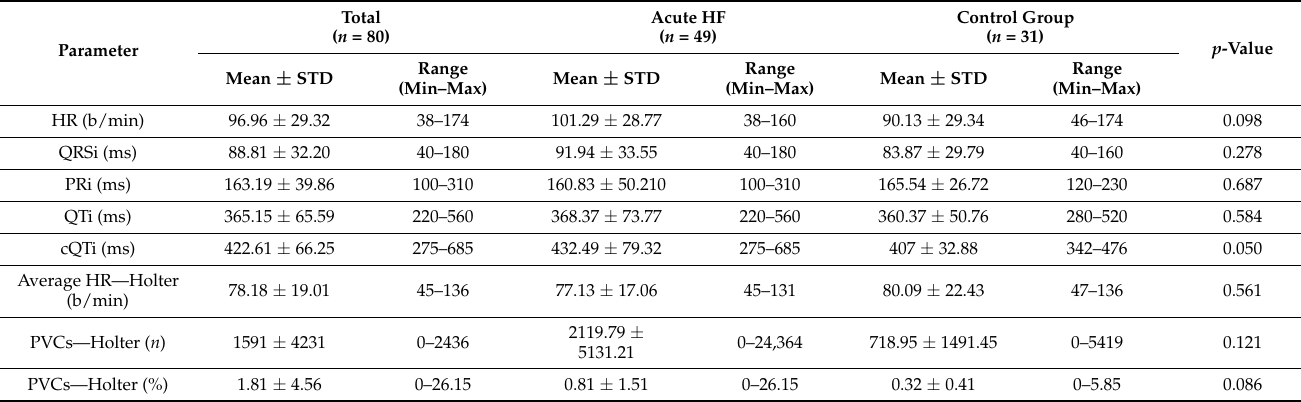
Table 8. ECG and Holter parameters in AHF and control group.